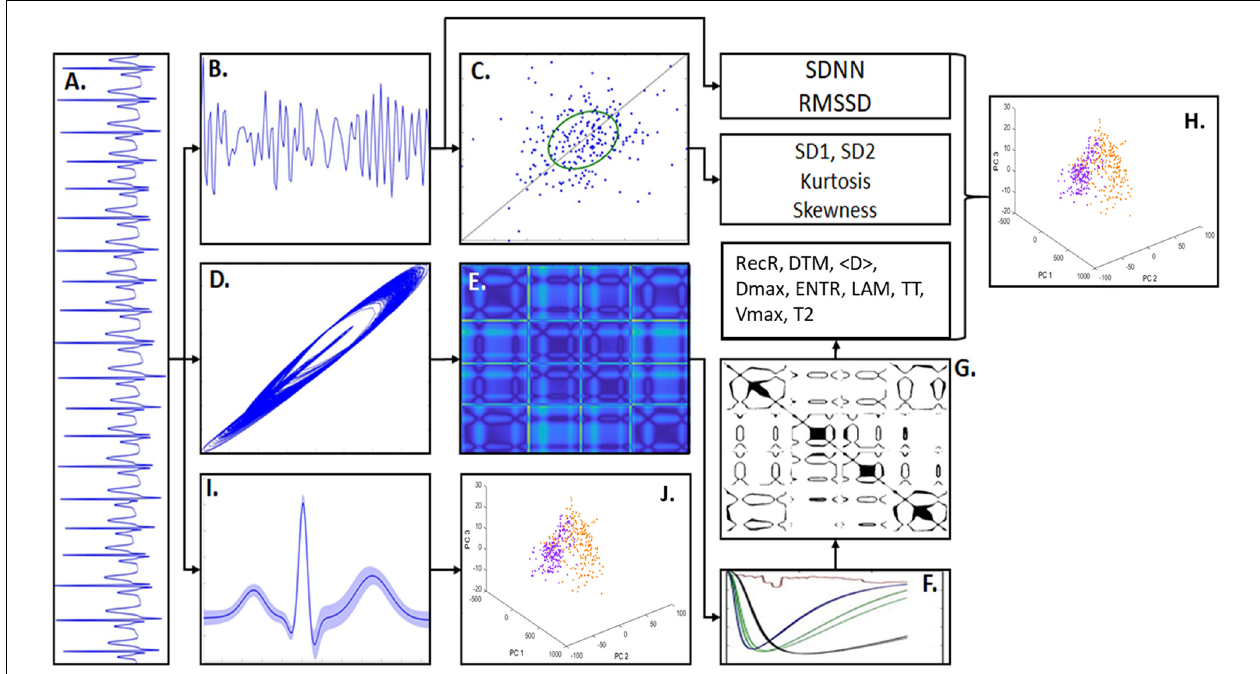
FIGURE 1 | Methodology scheme. (A) An example of artificial ECG pattern. By quantifying the R-R intervals from the ECG signals it was built the correspondent tachogram time-series consisted of R-R sequences. (B) From the ECG tachogram it was quantified two temporal features, standard deviation of n-n intervals (SDNN) and root mean square of successive differences (RMSSD) and built the Poincaré Map (PM). (C) The PM represents the scatter of points from the tachogram-space with the axis (RR n , RR n + τ ). The phase spaces of the ECG signals were also constructed, given by the coordinates (X t , X t + τ , X t + 2 τ ), which shows the signal trajectory seen in (D) . In (E) is shown the distance matrix, representing the Euclidian distance of each sample-point in relation to all other points in the phase-space. (F) Shows the recurrence quantification analysis (RQA) characteristics that allowed to select an epsilon threshold. (G) Shows an example of Recurrence Plot from the distance matrix given an epsilon. The RQA factors calculated in this work were: recurrence rate (RecR), determinism (DTM), mean diagonal length ( < D > ), maximum diagonal length (Dmax), Shannon entropy (ENTR), Trapping Time (TT), laminarity (LAM), maximum vertical length (Vmax), and time type 2 (T2). (H) Principal component analysis (PCA) calculated from the RQA factors highlights the differences between PD model and sham groups. (I) ECG waveform samples (PQRST complexes) extracted from the ECG patterns (considering its mean and SD). (J) PCA calculated from the ECG waveforms highlights the main differences in the signal